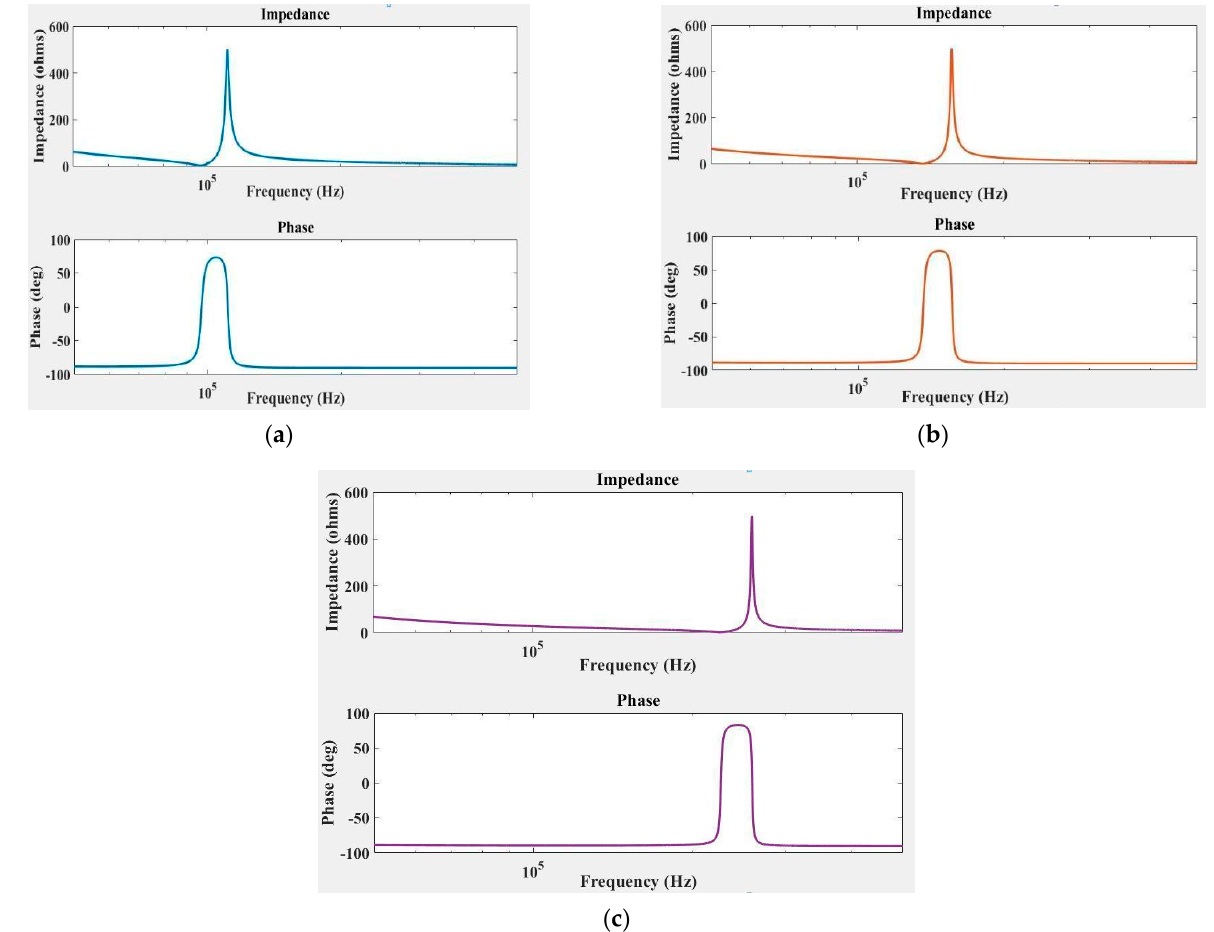
Figure 6. Simulink plots of input impedance w.r.t frequency ( a ) L r = 100 μ H, ( b ) L r = 50 μ H, and ( c ) L r = 18 μ H.